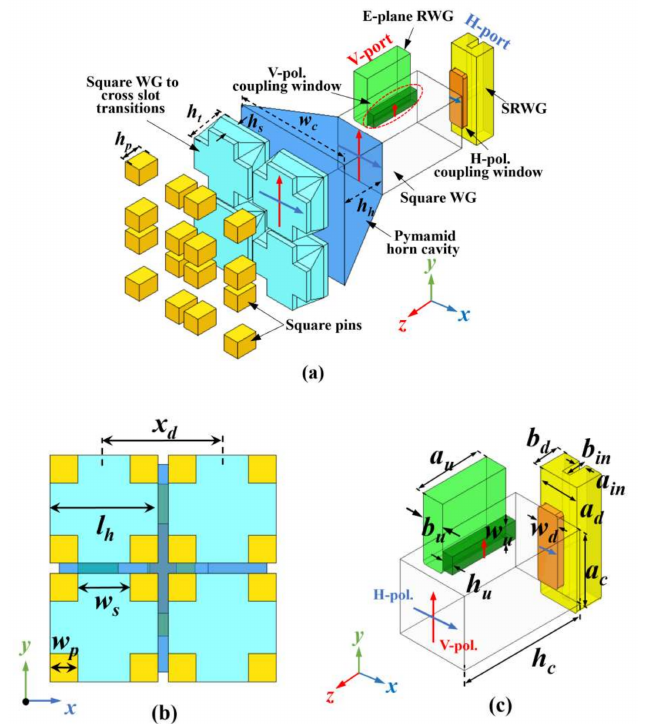
Figure 3. Configuration of the dual-polarization 2 × 2-unit ME-dipole subarray: ( a ) perspective view; ( b ) top view; ( c ) details of the OMT.